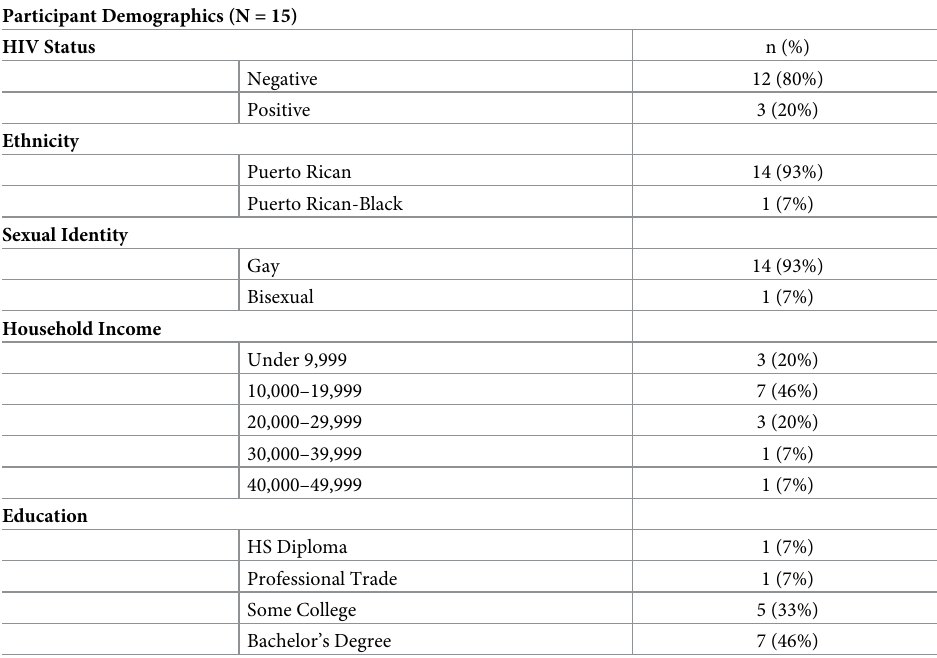
Table 1. Participant demographics for Hispanic MSM (mean age = 26.2) in San Juan,